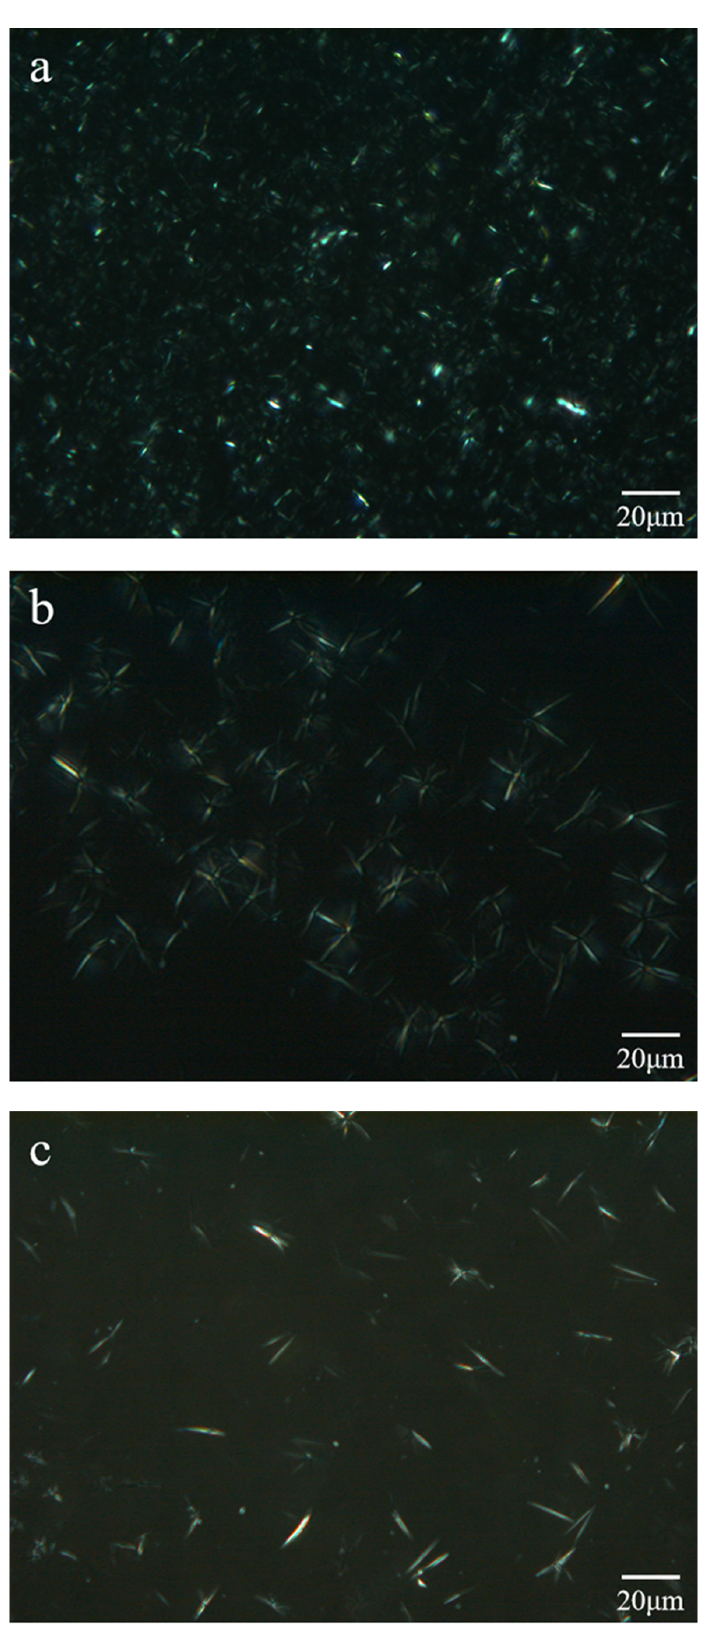
Figure 6. Paraffin crystal micrograph: ( a ) VGO4, ( b ) VGO4 + 100 ppm AMAC, and ( c ) VGO4 + 100 ppm EMAC.